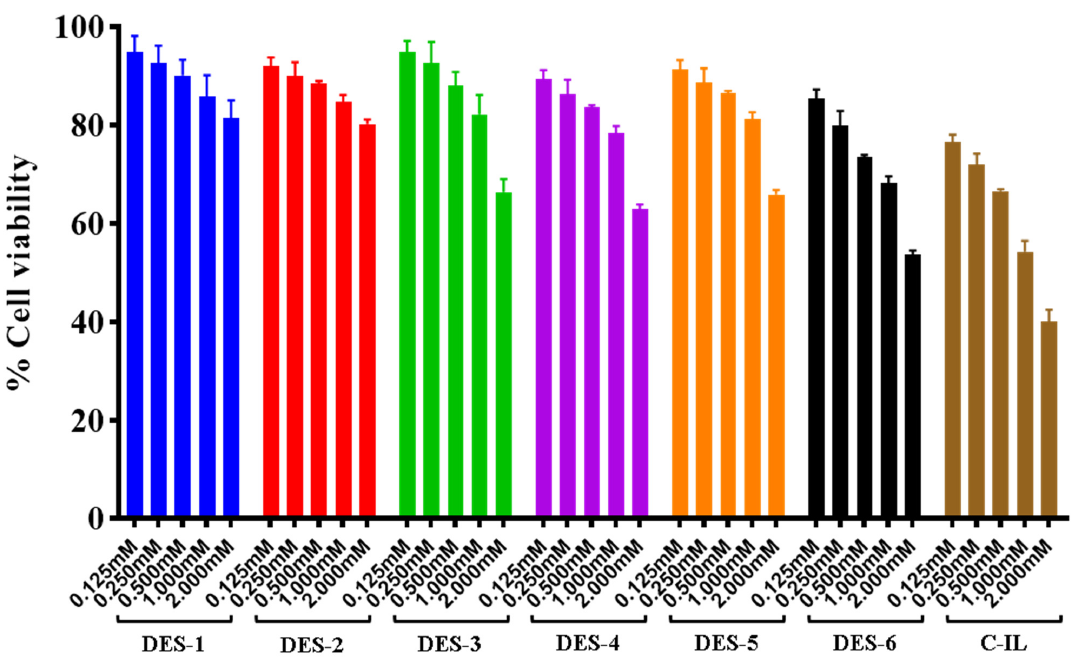
Figure 15. Effect of deep eutectic solvents on human cell line at their graduate concentrations.